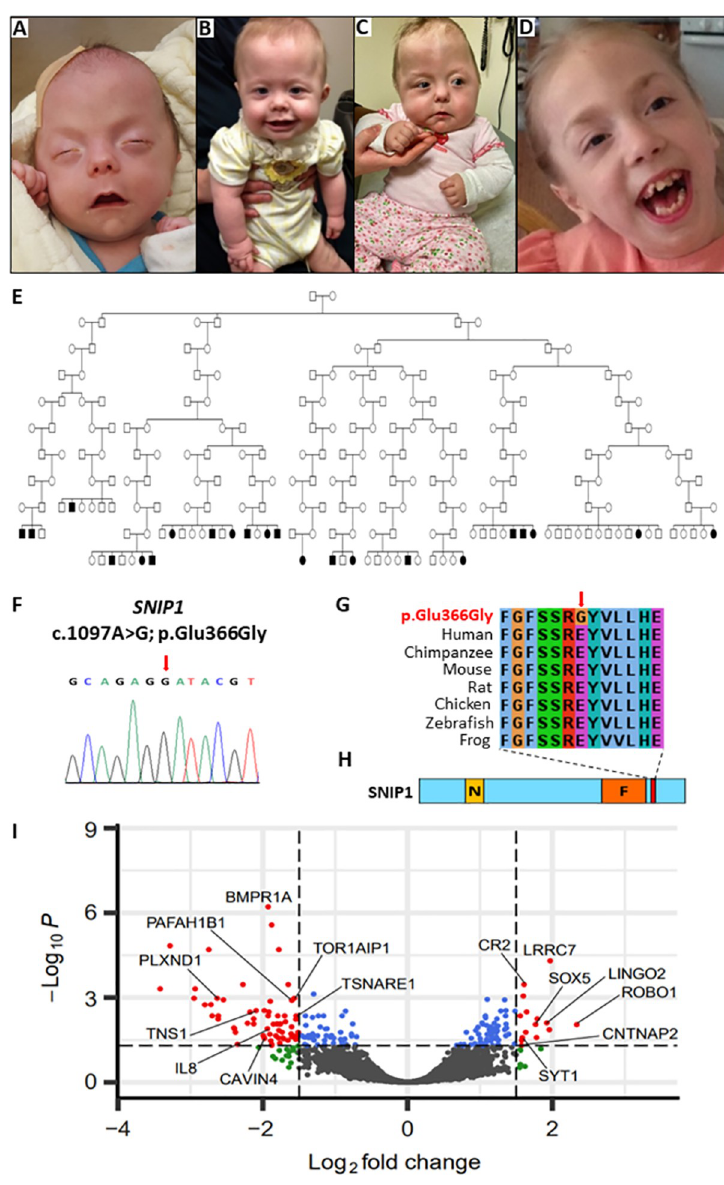
Fig 1. Homozygous SNIP1 c.1097A > G; p.(Glu366Gly) variant results in multisystem syndromic SNIP1 -related disorder within the Amish community (A-D) Clinical features of individuals affected by SNIP1 -related disorder. (A-C) Clinical features of three affected infants comprising of (A) craniosynostosis, proptosis, (A-C) downslanting palpebral fissures, microretrognathia, cupids bow upper lip and small upturned bulbous nose (B) hypotonia, tracheostomy, and gastrostomy feeding tube (C) metopic ridge, asymmetrical skull shape. (D) Photograph of older child, additional phenotypic features illustrated include; micrognathia, wide-mouth and dental crowding. (E) Simplified pedigree of 12 interlinking Amish nuclear families illustrating 22 individuals (of 35 investigated, which could be linked into a single pedigree using available Amish ancestry databases) affected with SNIP1 -related disorder and confirmed to be homozygous for the SNIP1 NM_024700.3: c.1097A > G, p.(Glu366Gly) variant. (F) Sequence chromatogram of the c.1097A > G, p.(Glu366Gly) variant (red arrow). (G) Multi-species alignment showing conservation of the polypeptide region encompassing the p.(Glu366Gly) alteration (red arrow). (H) Schematic diagram of the SNIP1 protein identifying the N-terminus nuclear localisation signal (NLS) domain (yellow box), C- terminus forkhead-associated (FHA) domain (orange box) and location of the c.1097A > G, p.(Glu366Gly) variant (red box). (I) Visualisation of differential expression results showing genes grouped by log(fold change) (x-axis) and log (adjusted p-value) (y-axis). Dashed vertical lines show the log(fold change) cut-off used to identify differentially expressed genes showing the largest relative expression changes (green points). The dashed horizontal line shows the log(adjusted p-value) cut-off used to identify significantly differentially expressed genes (blue points). Genes that are